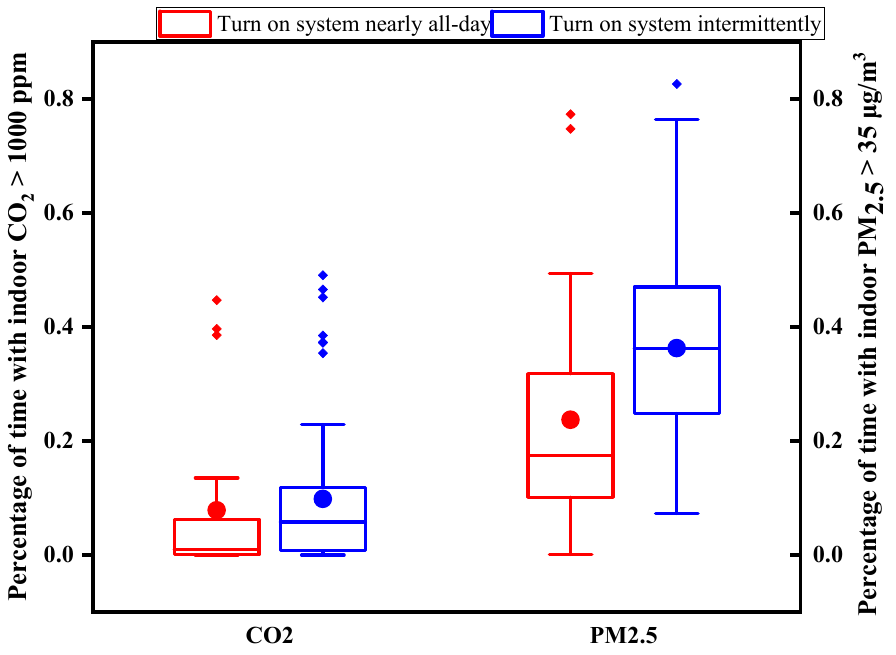
Figure 8. Percentage of time with hourly average indoor CO 2 concentration exceeding 1000 ppm and indoor PM 2.5 concentration exceeding 35 µ g/m 3 .